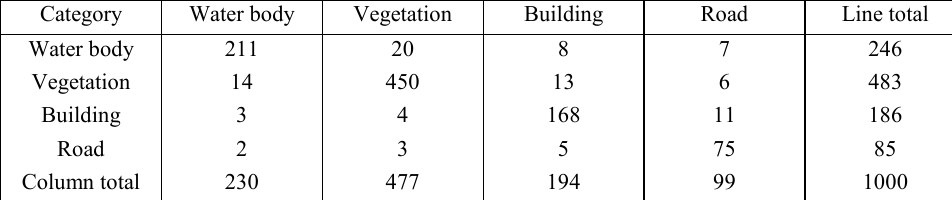
Table 3. CNN classification obfuscation matrix